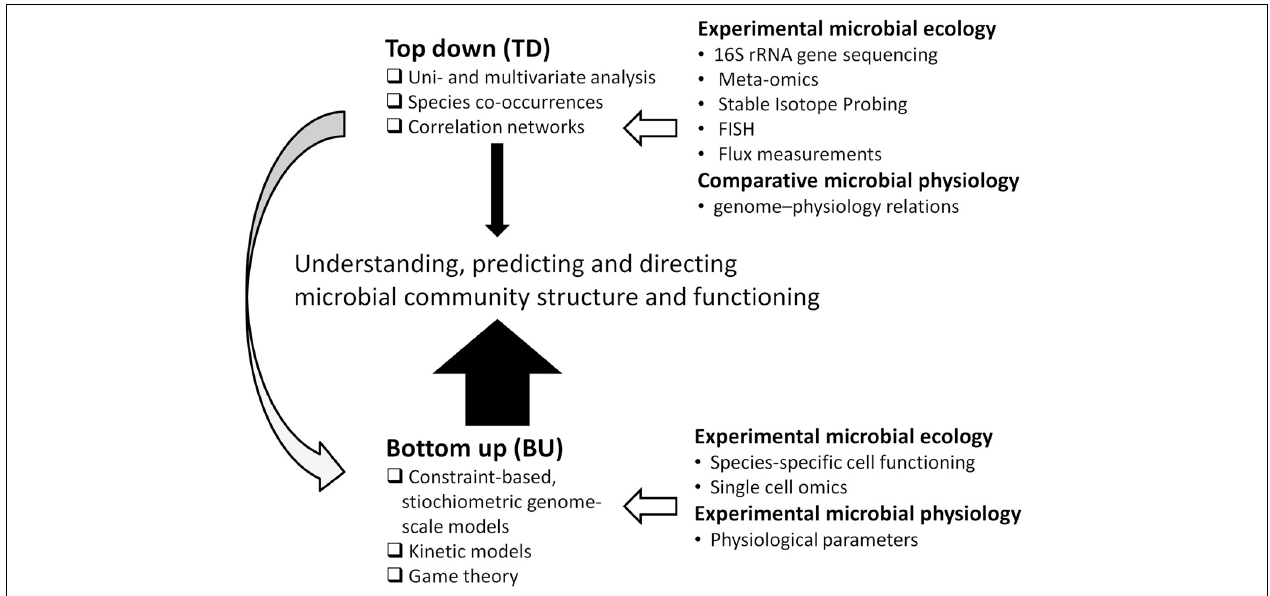
FIGURE 2 | Bottom-up (BU) vs. top–down (TD) approaches to model microbial community structure and its functioning. In this paper we advocate an approach that is strongly BU (as indicated by the thick, solid